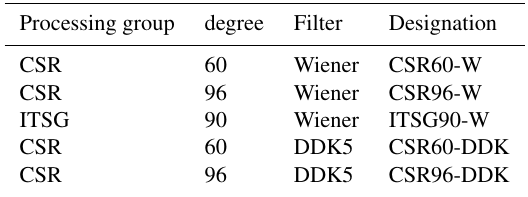
Table 1. Designations of filtered gravity field solutions. Processing